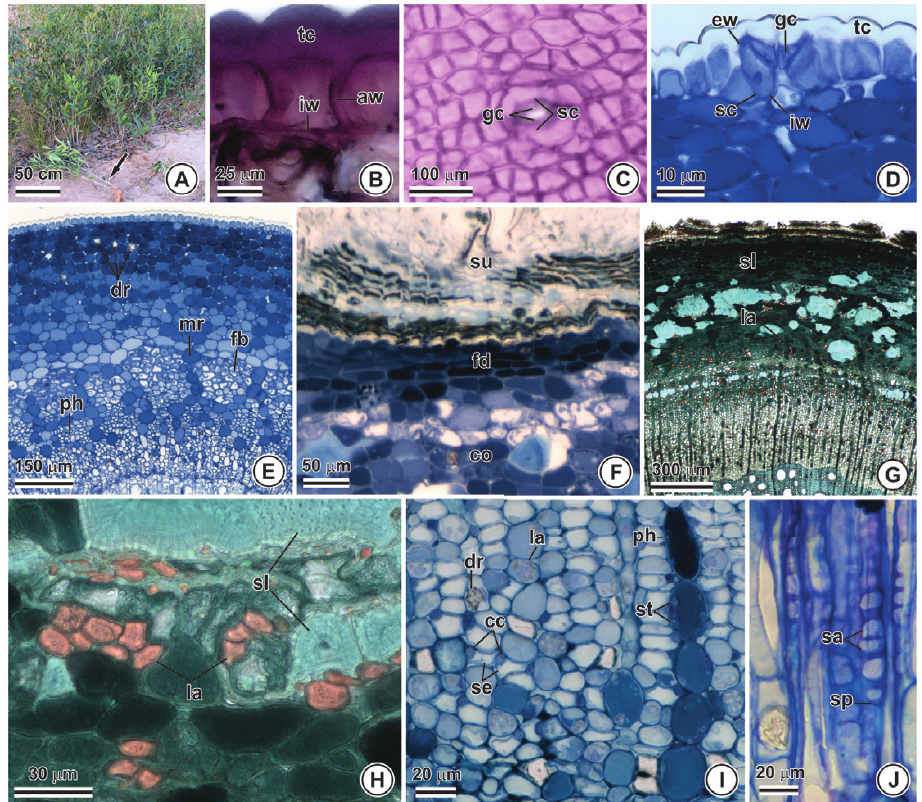
Figure 3 - Aerial stem of Tontelea micrantha . (A) General view. (B, D-I) Cross section. (B) Paradermal section. (J) Longitudinal section. (A) General aspect of the clone emerging from the underground stem (arrow). (B) Epidermal cells with the cuticle coating the anticlinal and periclinal walls. (C-D) Stomata. (E) Primary structure. (F-J) Secondary structure. (F) Periderm and cortex. (G) Periderm, cortex with sclereids and laticifers, and secondary phloem. (H) Detail of the cortex showing sclereids and laticifers. (I-J) Detail of the secondary phloem showing laticifers. aw: anticlinal wall; cc: companion cell, co: cortex; dr: druse; ew: external periclinal wall, fb: fi ber; fd: phelloderm; gc: guard cell; iw: inner periclinal wall; la: laticifer; mr: medullary ray, ph: phenolic content; sa: sieve area, sc: subsidiary cell; se: sieve element; st: starch grain; sl: sclereid; sp: sieve plate; su: suber; tc: thick